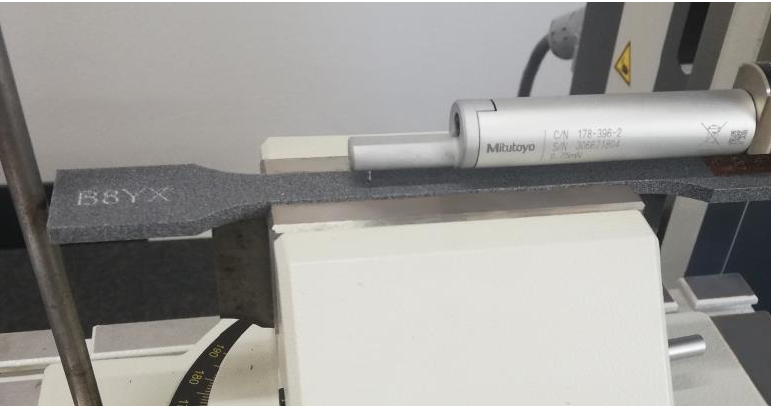
Figure 8. The stand for measuring surface roughness while measuring a PP sample.